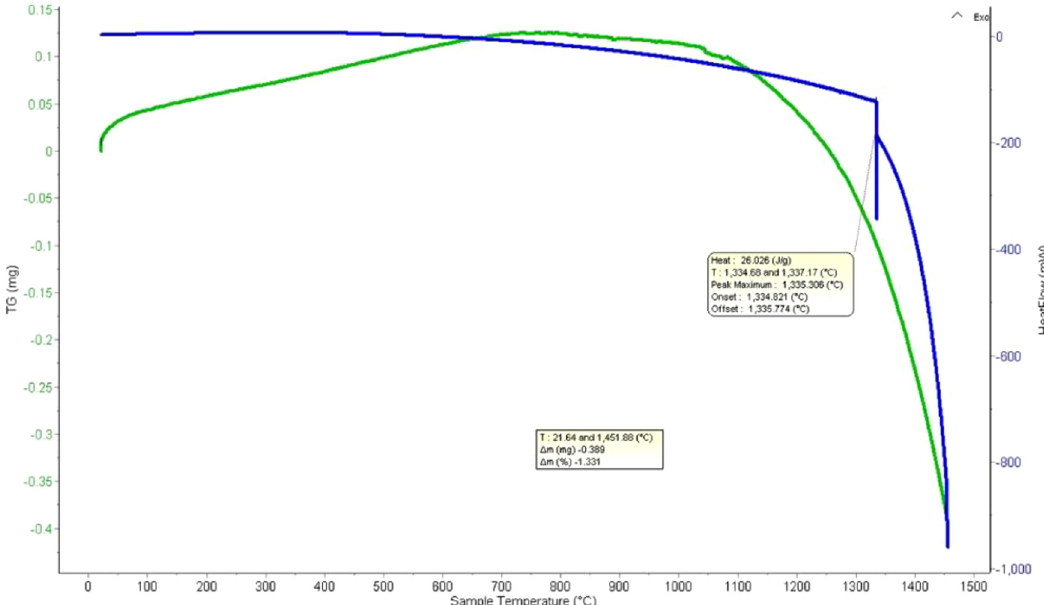
Fig. 12. The DSC-TG curve for yttria-doped zirconia coatings on Nb